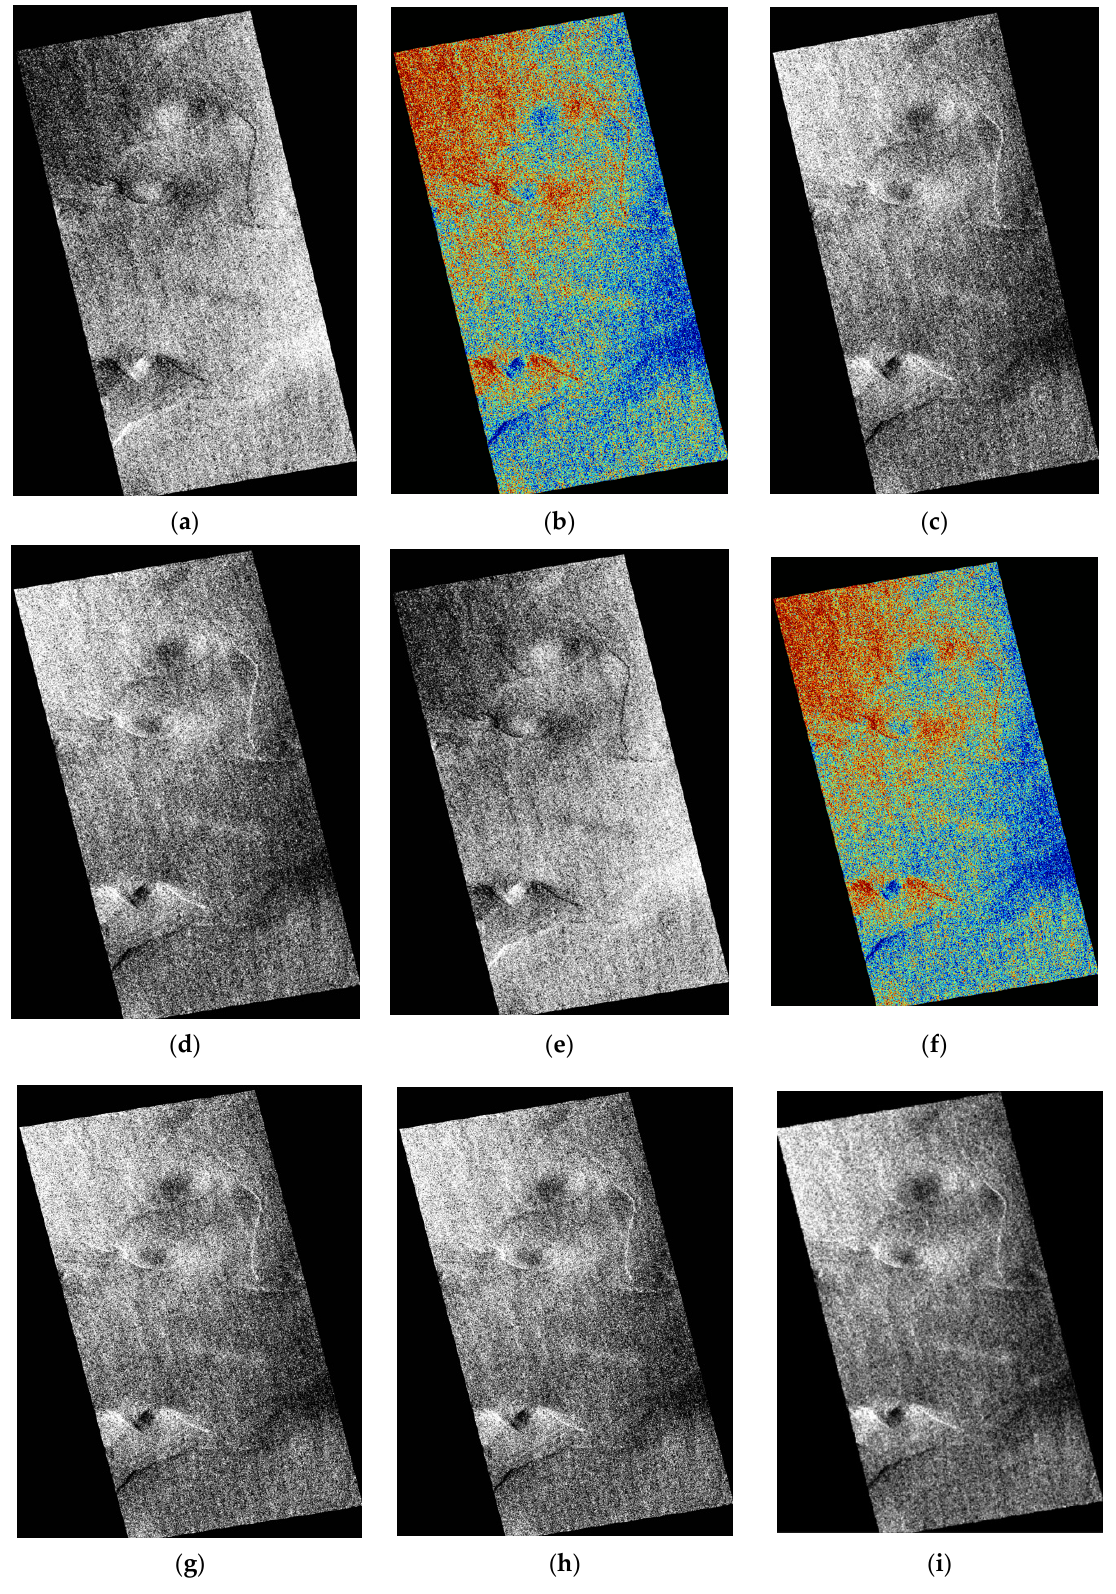
Figure 6. The CP feature images showing better performance for “white” eddy detection under data #A: ( a ) Pd , ( b ) SE I , ( c ) Dbl , ( d ) g 0, ( e ) g 3, ( f ) l 1, ( g ) lambda , ( h ) ms , and ( i ) σ HH